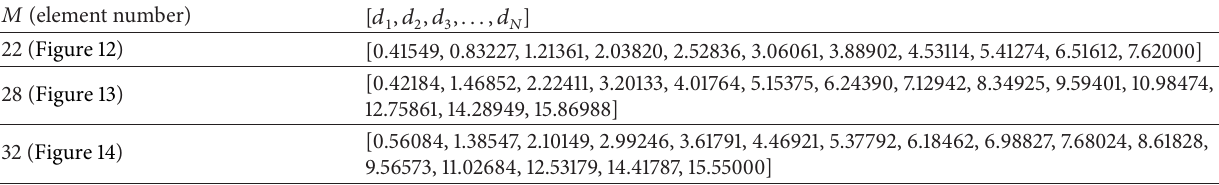
Table 9: The element positions ( 𝑑 𝑚 ) normalized with respect to 0.5 𝜆 for the array patterns given in Figures 12–14.